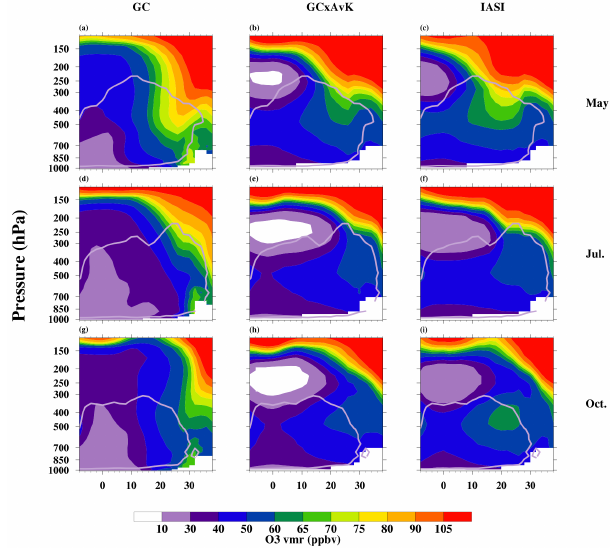
Figure 6. Same as Fig. 3 for O 3 . Figure 7. Same as Fig. 2 for O 3